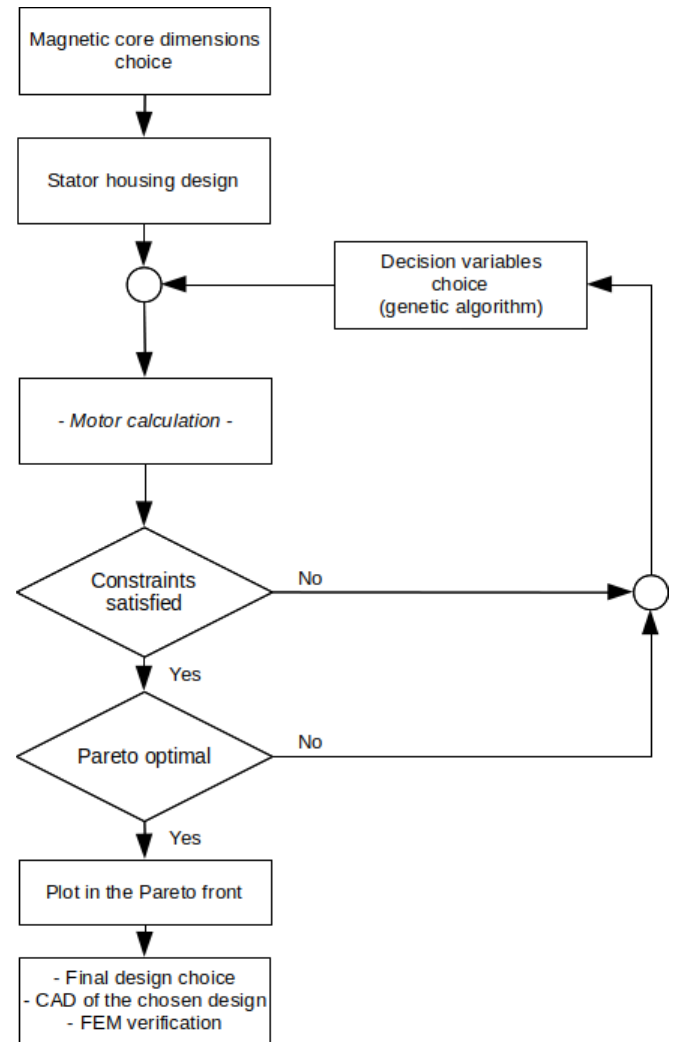
Figure 7. Flowchart of the optimization